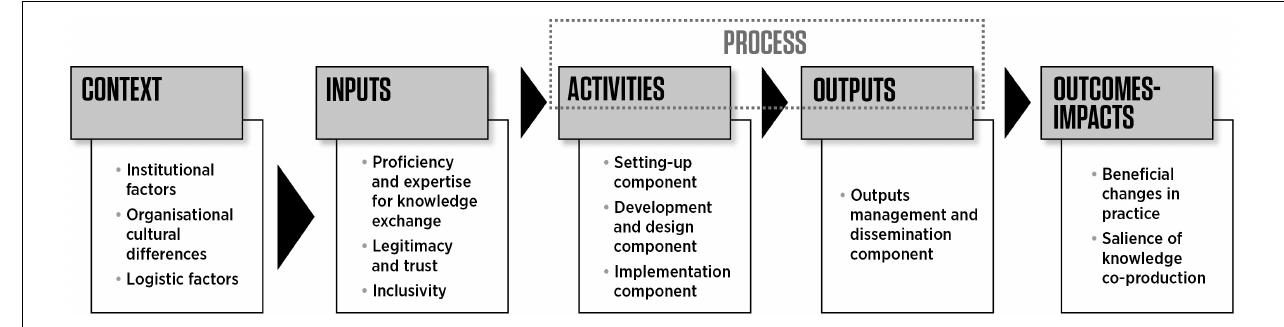
FIGURE 1 | Variables of knowledge co-production work. Source: Djenontin and Meadow (2018).